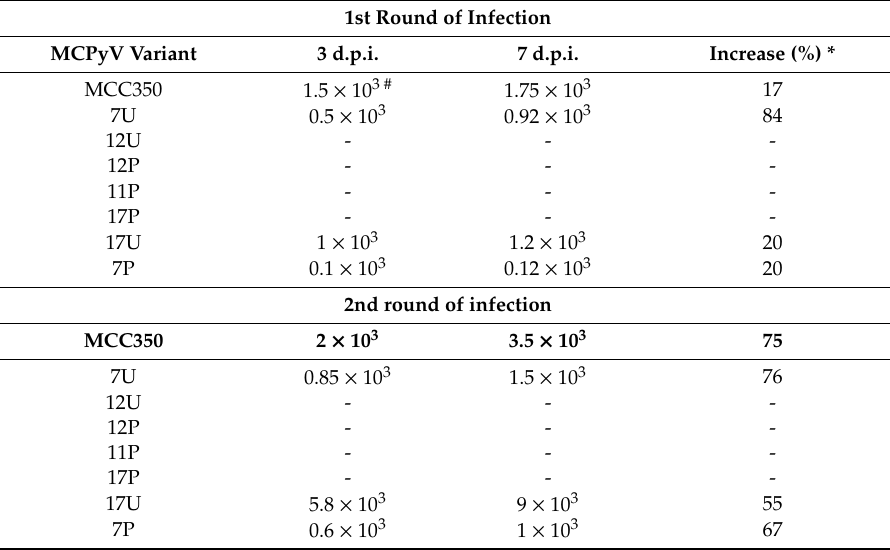
Table 2. Replication e ffi ciency in A549 as determined by